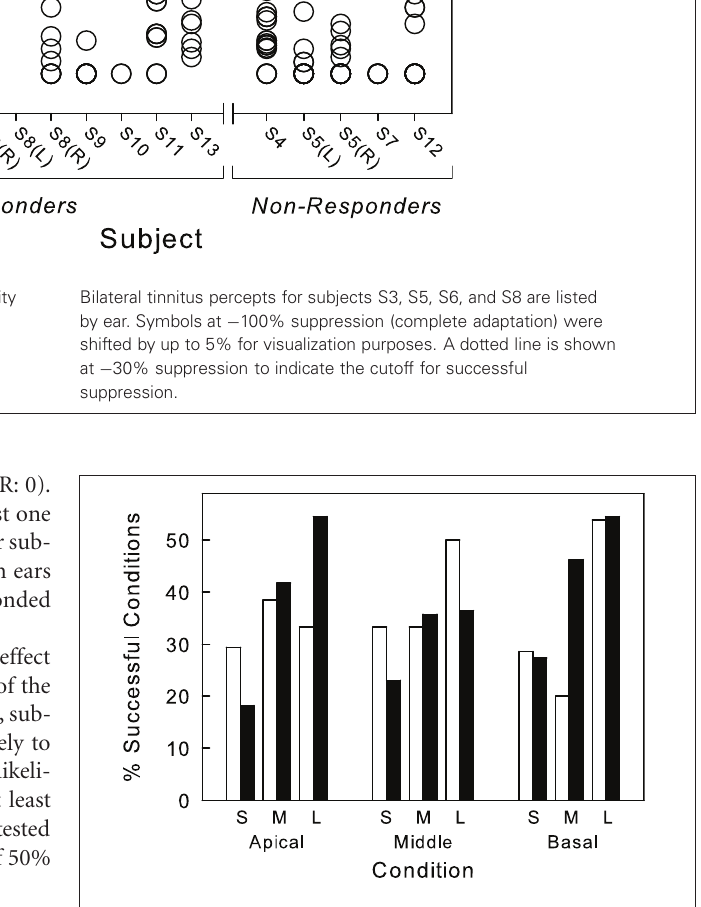
FIGURE 4 | Percentage of successful suppression conditions, by condition. Percentage of successful conditions (achieving tinnitus suppression of − 30% or greater) of conditions tested are reported by stimulus condition. Open bars denote low rate stimuli; filled bars denote high rate stimuli. Electrodes for an apical, middle and basal place are grouped in clusters, and loudness levels are shown for each electrode (S = soft; M = medium; L =